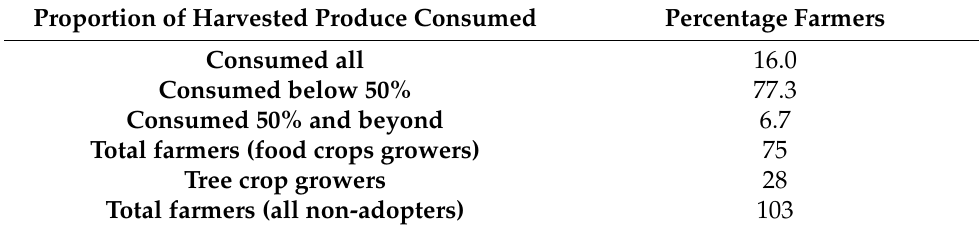
Table 5. Percentage of harvested produce of major crops cultivated by non-adopters. Note: Some of the non-adopters have tree crops (cocoa, cashew, orange) as their major crops. These farmers were excluded from the calculations since their crops are not for direct domestic consumption and were processed in factories. The calculations were based on ‘Total farmers (food crops